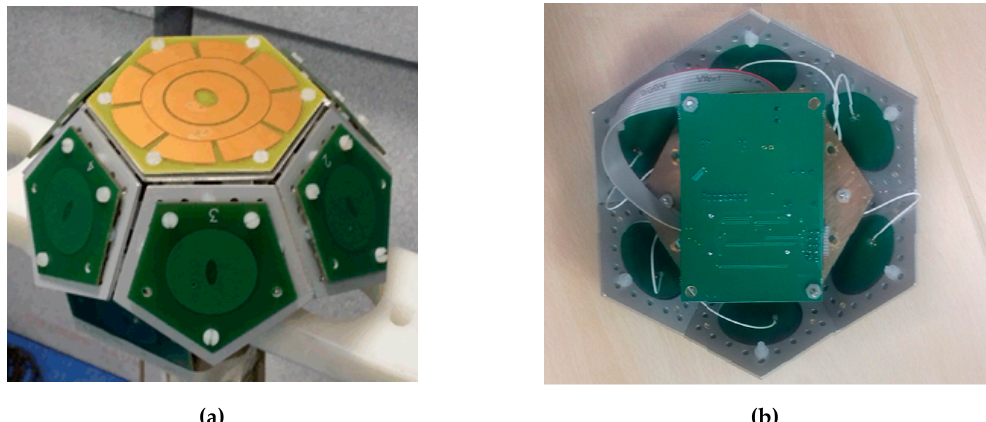
Figure 3. Switched Beam Antenna prototype: ( a ) upper view; the top antenna in this realization presents some parasitic elements to improve the radiation gain of antenna #8; ( b ) rear view, with the control unit board in view.